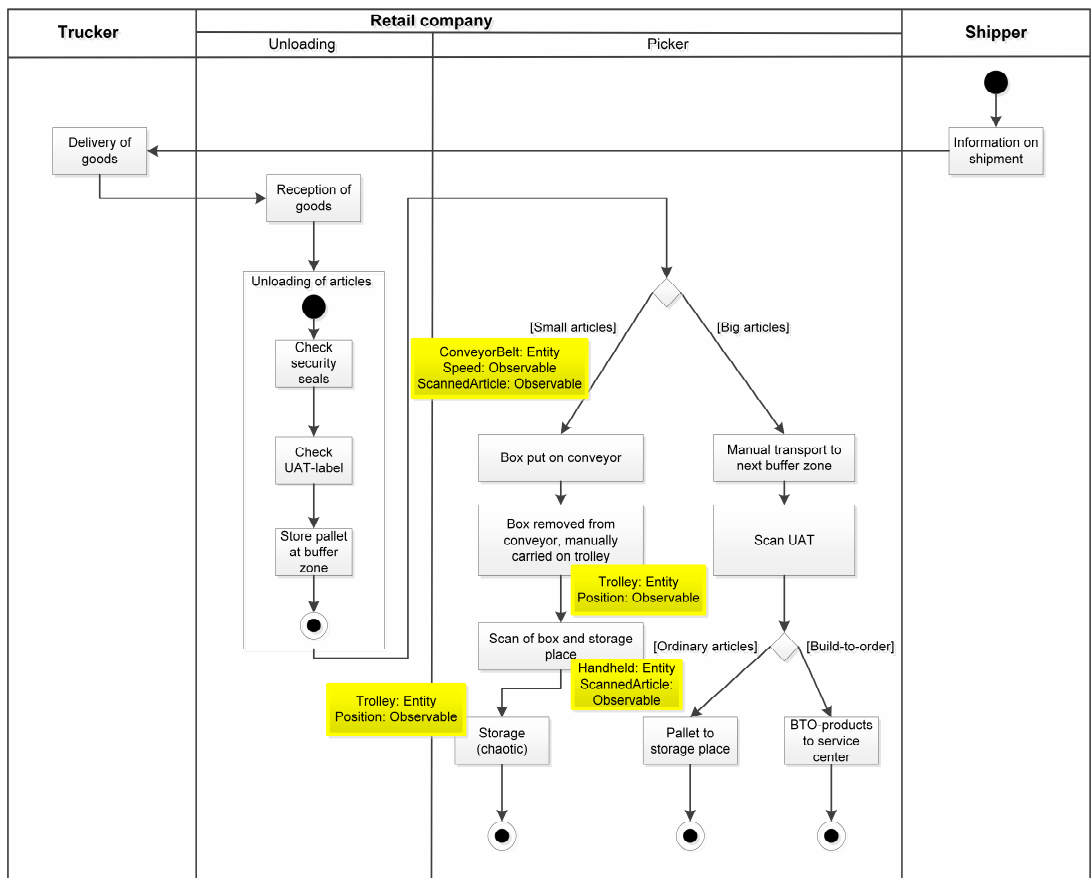
Figure 14. Activity diagram of the storage use case example with exception-related events.